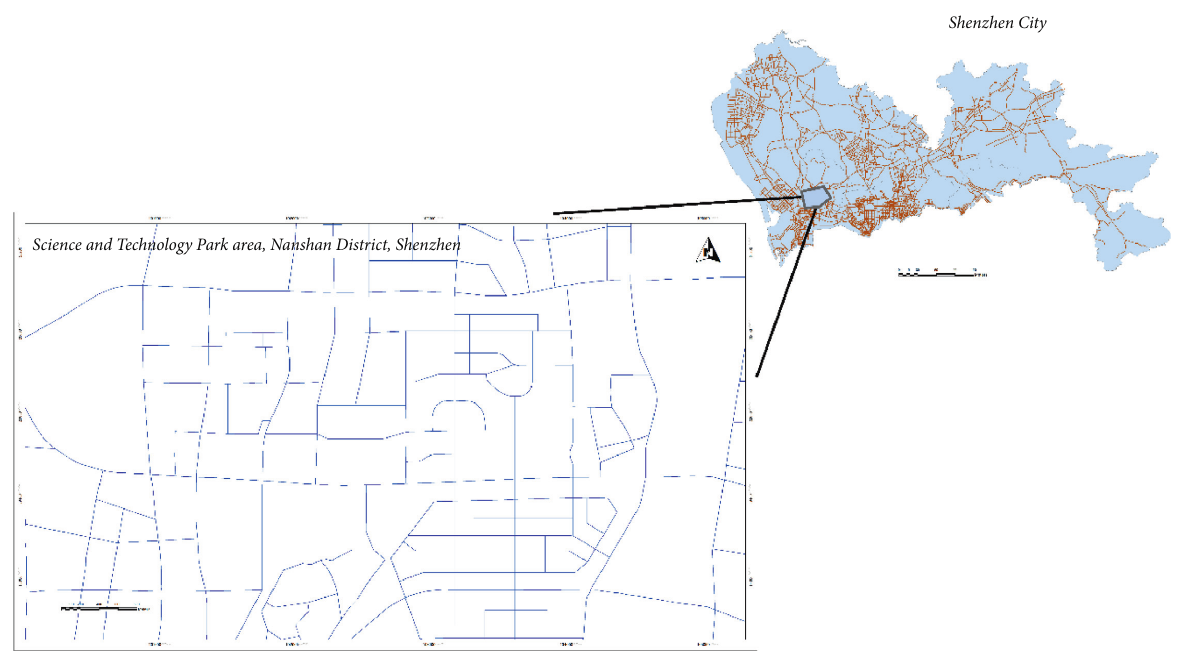
Figure 3: Electronic map of road network.